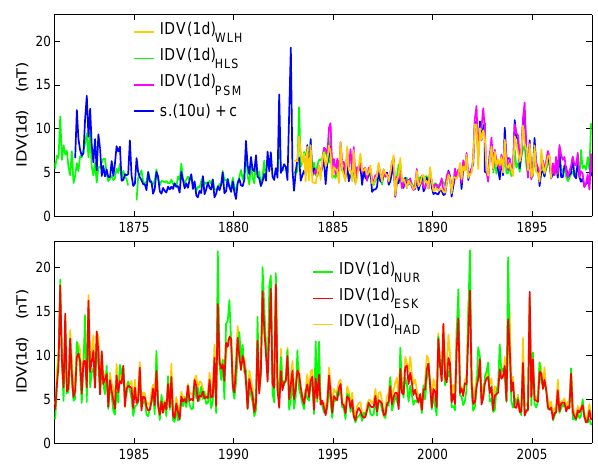
Fig. 15. Monthly means of IDV(1d) from various sources. The up- per panel shows early data (1871–1898) and the lower panel an in- terval of modern data of the same duration (1981–2008). The up- per panel shows data from Parc St Maur, IDV(1d) PSM (in mauve), from Wilhelmshaven, IDV(1d) WLH (in orange), and from Helsinki, IDV(1d) HLS (in green), along with the scaled u index, s · ( 10 u) + c where s and c are given by the regression shown in Fig. 9 (in blue). (Note that the IDV = 10 u at this time). The lower panel shows data from Eskdalemuir, IDV(1d) ESK (in red), Nurmijärvi, IDV(1d) NUR (in green) and Hartland (in